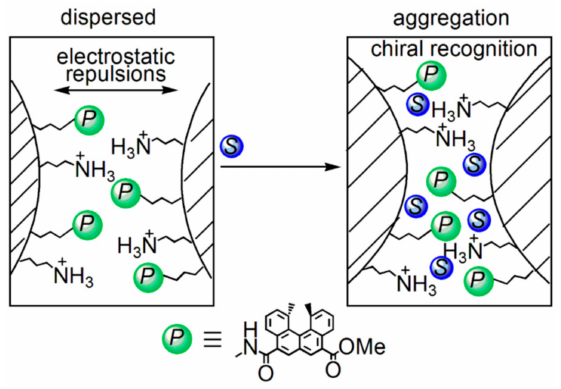
Figure 36. Proposed mechanism of ( P )-nanoparticles precipitation. S represents chiral cylindrical molecular complex.